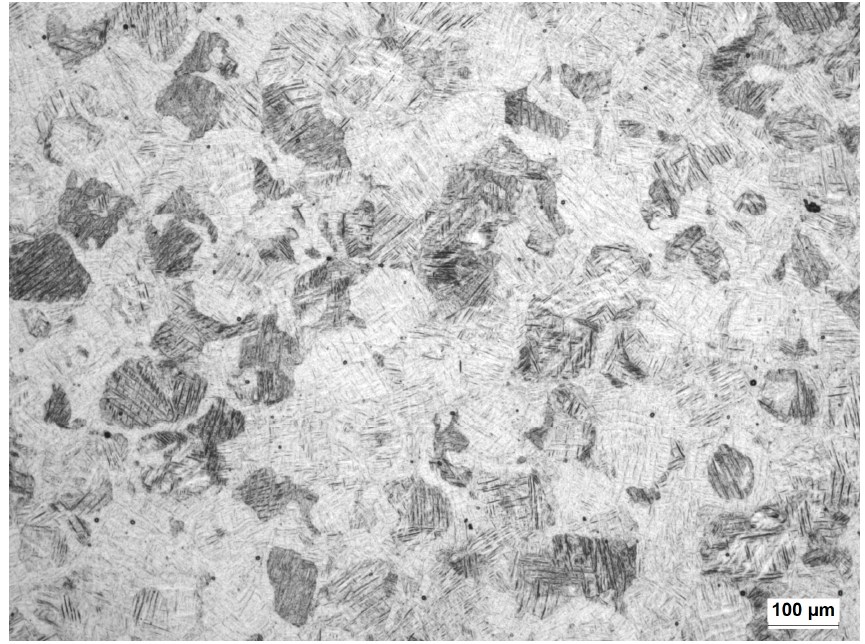
Figure 2. LOM micrograph of Ti-6Al-4V ELI alloy processed by L-PBF. The microstructure is com- posed of an acicular martensitic structure in prior β grains.